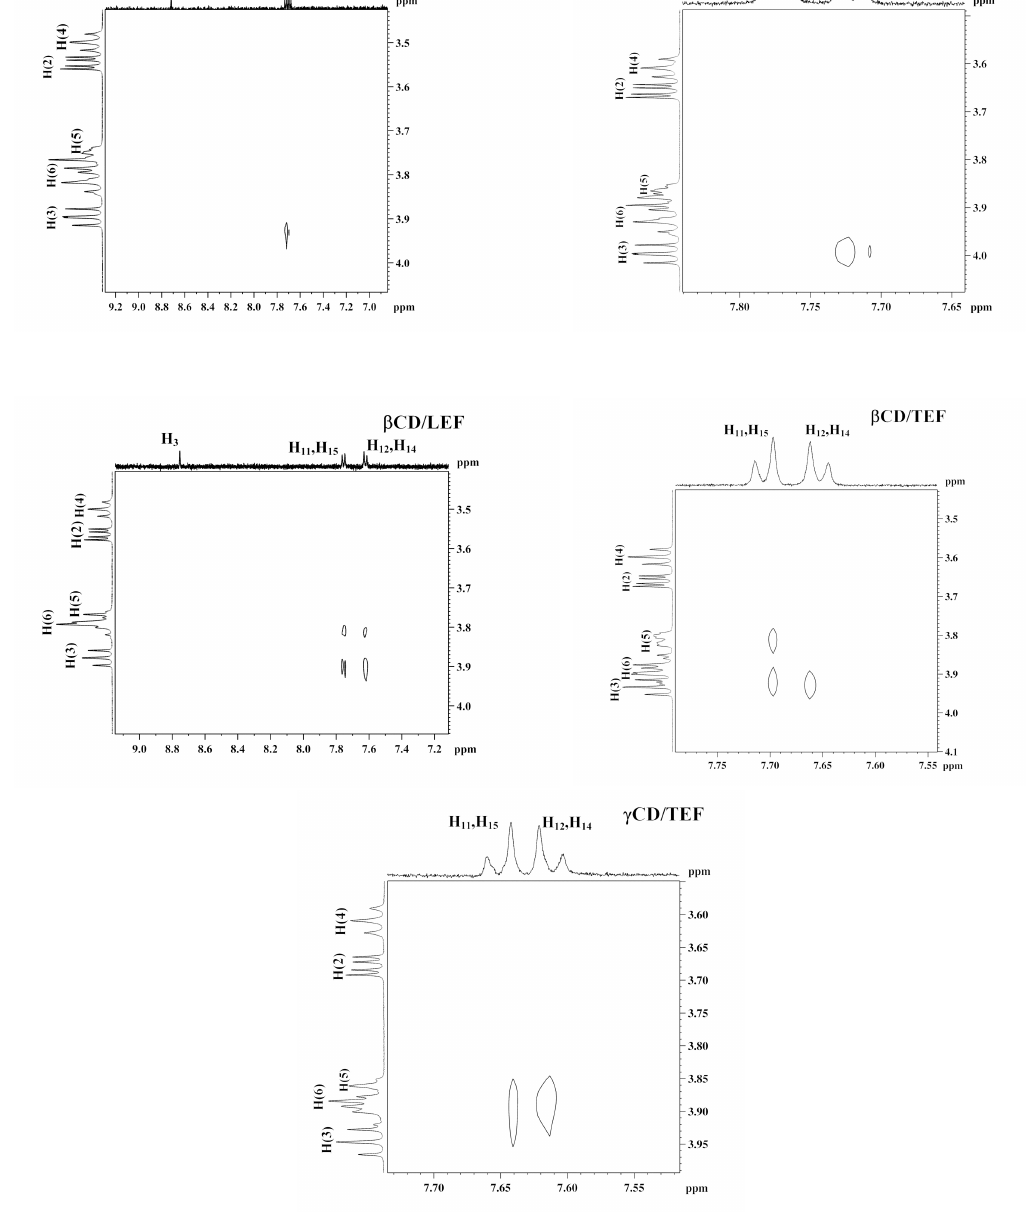
Figure 2. 2D 1 H NMR ROESY spectra of complexes of CDs with LEF and TEF.